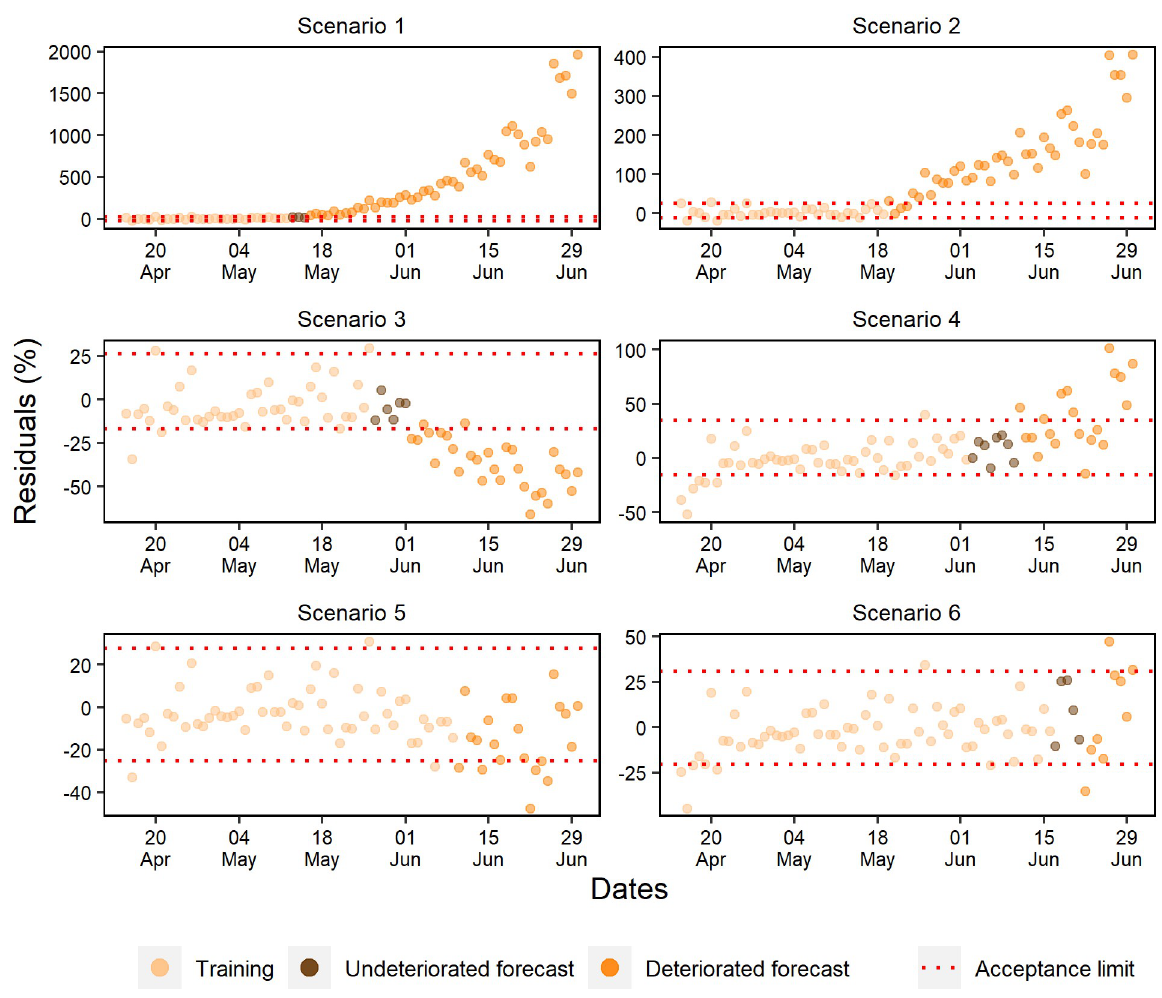
Fig 13. Percentual residuals for daily deaths of the 6 analyzed